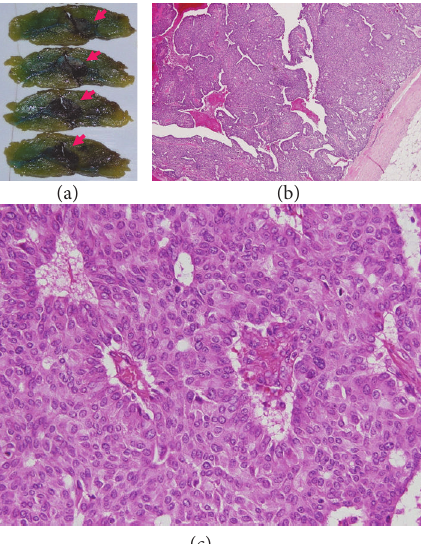
Figure 3: (a) A solid tumor 25 × 30 × 25 mm in size whose surface is sharply demarcated from the surrounding tissue (arrow) is seen at the cut surface of the specimen. Both necrosis and hemorrhage are present. (b) Sections of paraffin-embedded tissue were prepared and stained with HE double stain for light microscopic observation. A histological section reveals intraductal carcinoma showing a solid papillary growth pattern and the neoplastic lesion is encapsulated by bands of dense fibrosis (HE stain, original magnification × 40). (c) Nuclear palisading around fibrovascular cores was found (HE stain, original magnification × 400).